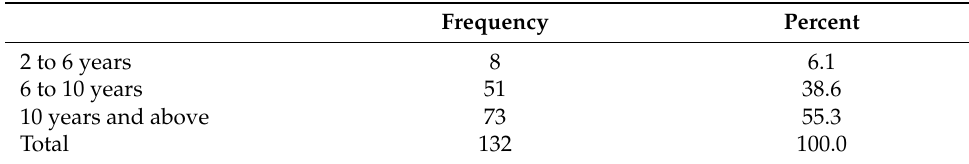
Table 4. Valuer experience.